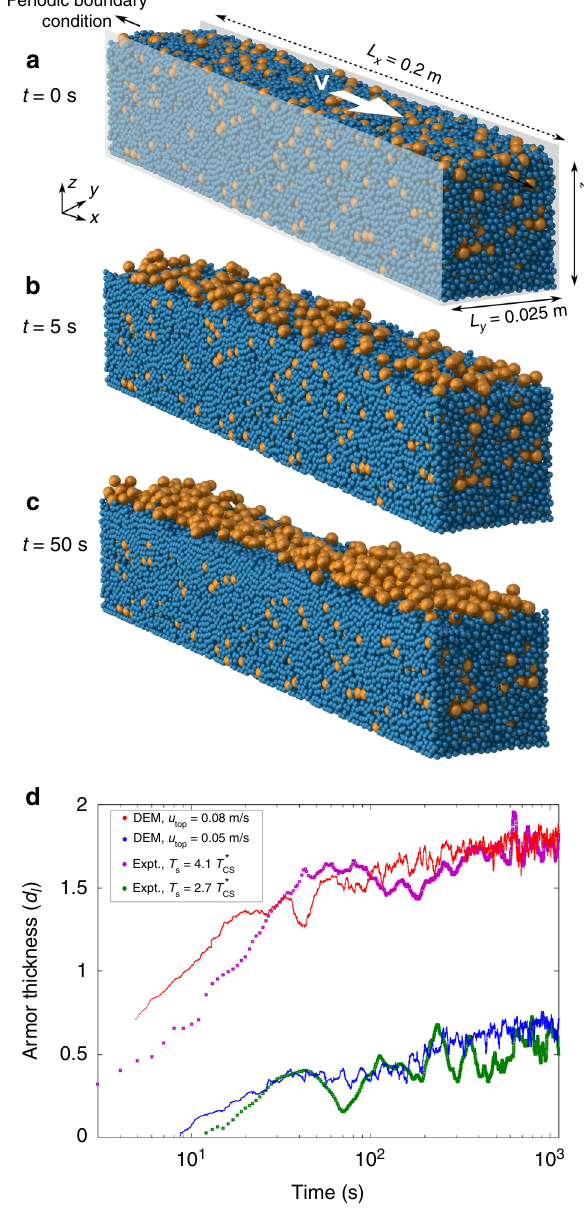
Fig. 5 DEM simulation of a dry sheared granular bed with u top = 0.08 m s − 1 equivalent to the fl uid-driven sheared granular bed at τ (cid:1) s ¼ 4 : 1 τ (cid:1) cs . The top layer of large grains that drives particles underneath is shown in Supplementary Fig. 9. a Model domain and initial conditions. Granular pack shown after b 5 s and c 50 s of shearing. Note rapid segregation, and depletion of the near-surface zone of large grains, as a consequence of bed load. d Evolution of armour thickness for the DEM model and experiments at two equivalent driving stresses indicated in the